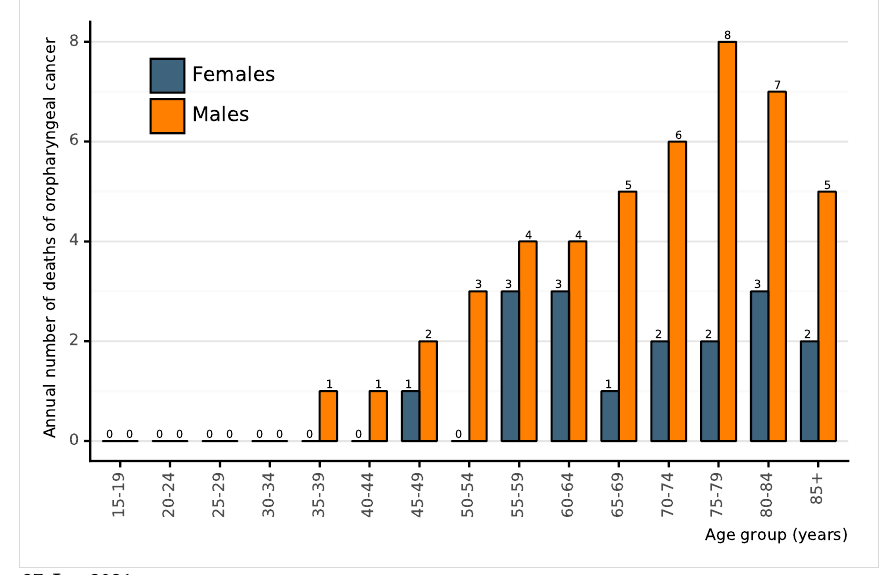
Figure 39: Annual number of deaths of oropharyngeal cancer in Peru (estimates for